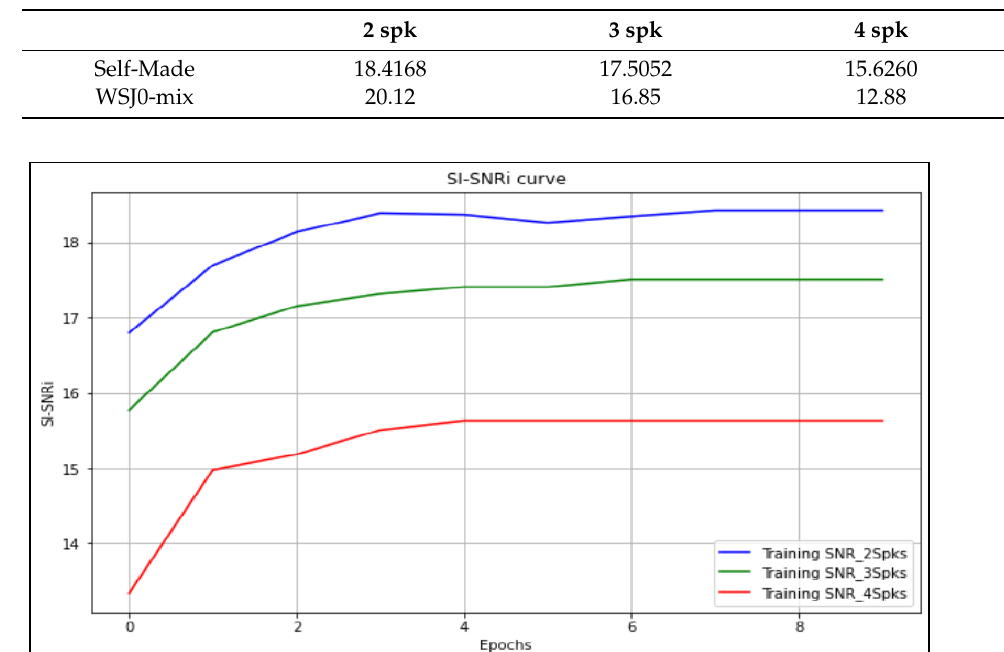
Figure 7. SI-SNRi curves for various mixed numbers of speakers.